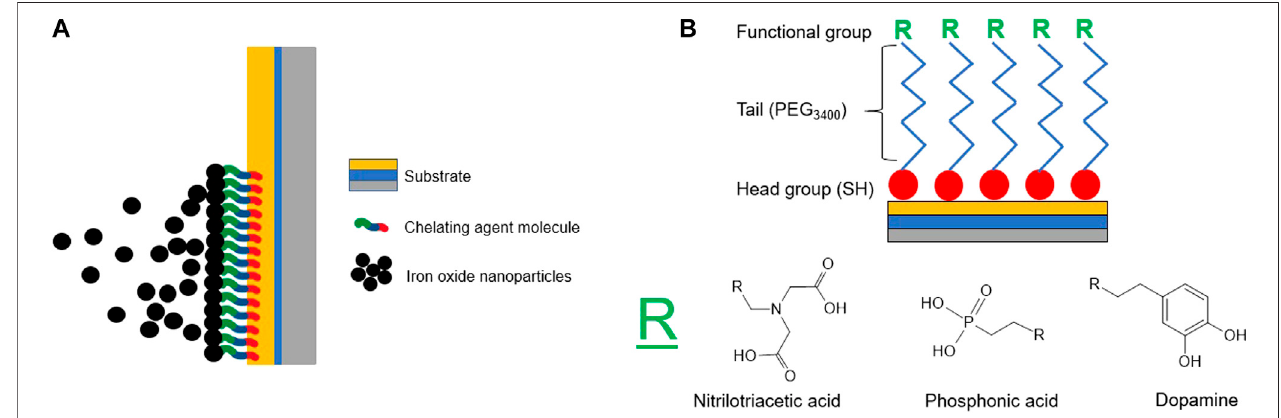
FIGURE 2 | (A) Illustration of the substrate functionalized with chelating agent molecules for use during the electrophoretic deposition of iron oxide nanoparticles. (B) Expected structure of the chelating agent molecules as they are functionalized on an Au/Ti/Si substrate, including a thiol head group, a PEG3400 spacer, and functional group